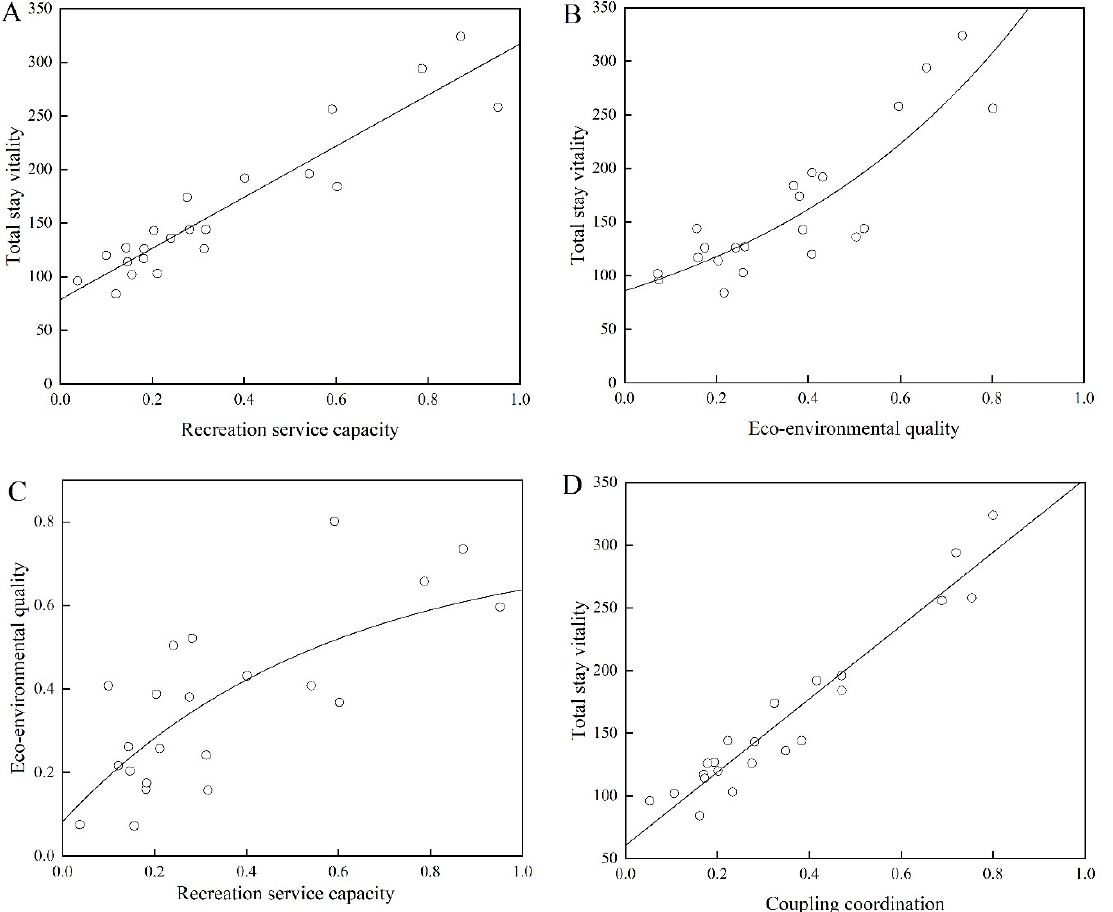
Figure 7. Results of fitting spatial characteristics of waterfront with spatial vitality values. ( A ) The llinear fitting between total stay vitality and RS; ( B ) The llinear fitting between total stay vitality and eco-environmental quality; ( C ) The llinear fitting between eco-environmental quality and RS; ( D ) The llinear fitting between total stay vitality and coupling coordination.